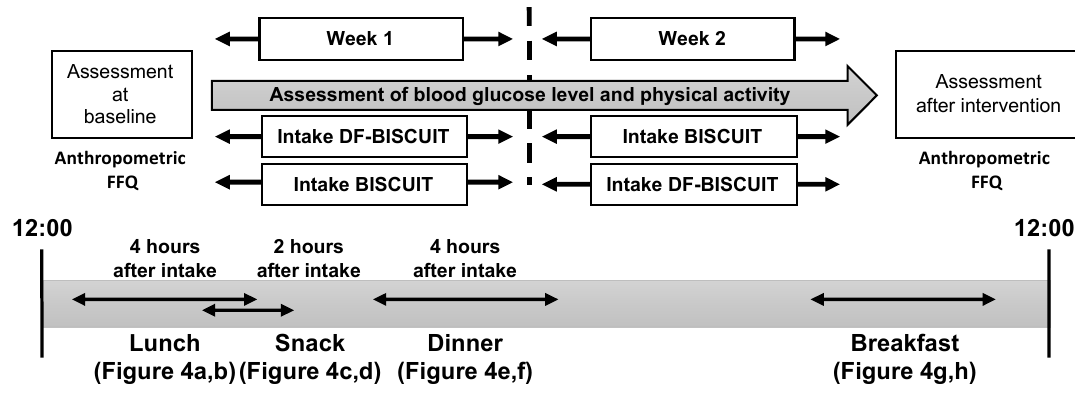
Figure 1. Study protocol. FFQ, food frequency questionnaire.